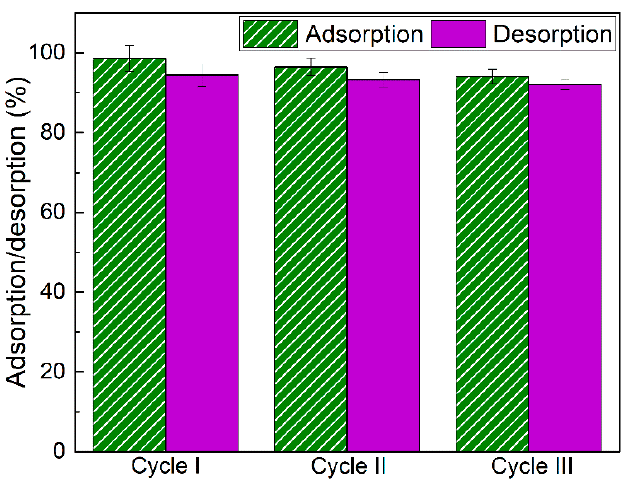
Figure 9. Desorption and reusability of the CMT-g-PANI@Fe 2 O 3 bioadsorbent for amoxicillin adsorption.